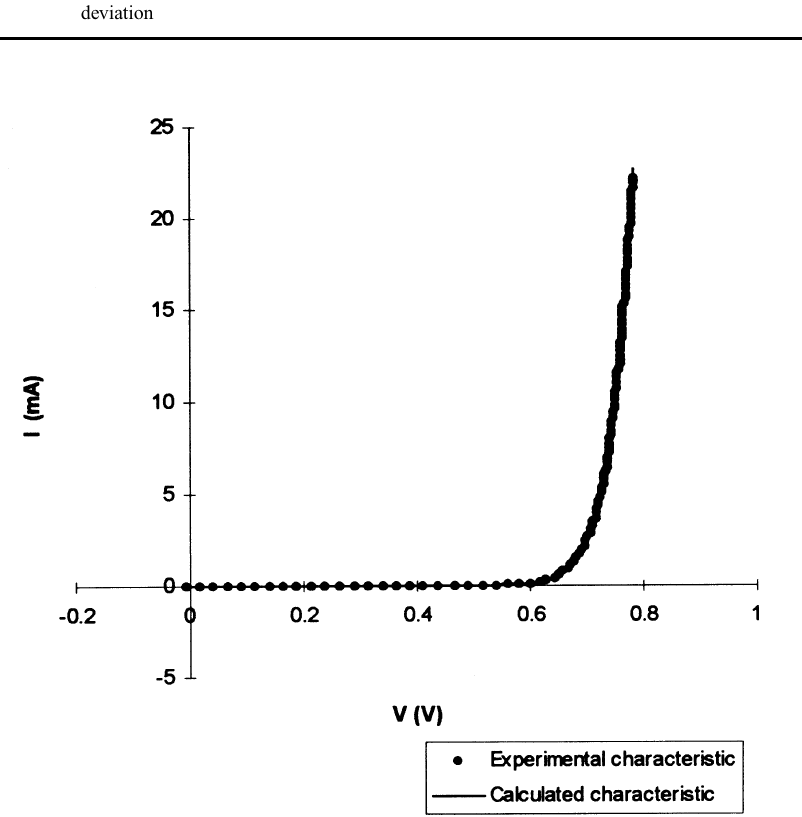
FIGURE 5 Experimental characteristic of the emitter-base junction of a 2N2904A transistor (dots) and its fit by our method